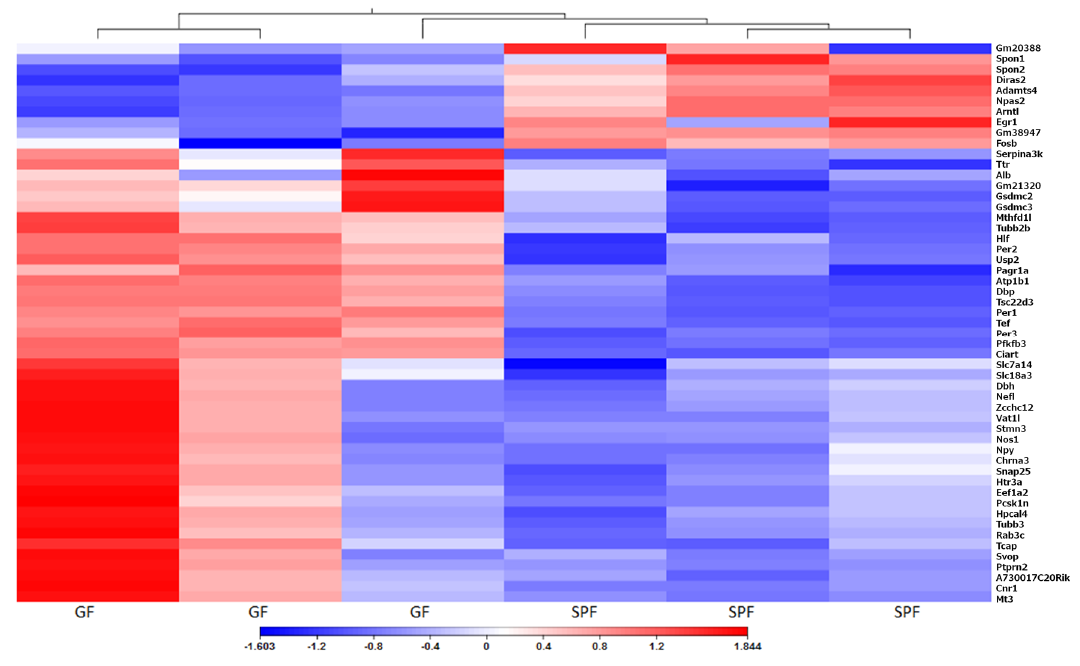
Figure 3. Heat Map of di ff erentially expressed genes. Comparison of urinary bladder gene expression between GF and SPF mice. Values represent log 2 (fold change) with FDR less than 0.01, Euclidian distance, complete linkage. Table 3. List of biological processes enriched in GF bladder tissue obtained by Gene Ontology analysis. # (Total Number in Number GO Biological Process Reference Genome)